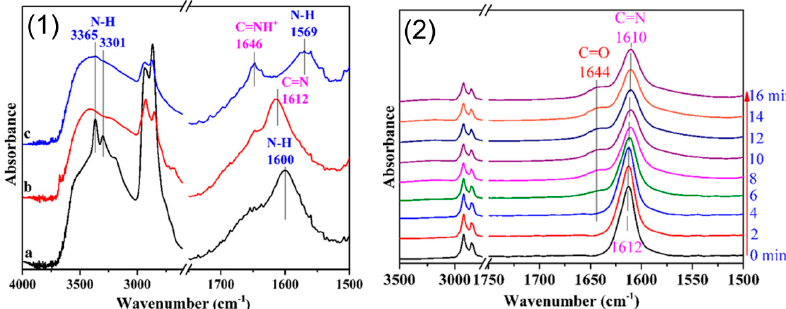
Figure 6. ( 1 ) FTIR spectra of (a) TOTDDA, (b) DBU, and (c) mixture of TOTDDA and DBU (TOTDDA:DBU was 10:1). The protonation of DBU by TOTDDA indicated that DBU could activate the -NH 2 group of TOTDDA. ( 2 ) In situ ATR-FTIR spectra of DBU (C=N) and DBU · CO 2 (C=O) collected at different periods of reaction time. The new band at 1644 cm − 1 is assignable to C=O and this implies the formation of the complex of DBU · CO 2 . Reaction conditions: DBU 2 mmol, CO 2 8 MPa, 60 ◦ C. Reprinted with permission from [98] (Copyright 2018 John Wiley and